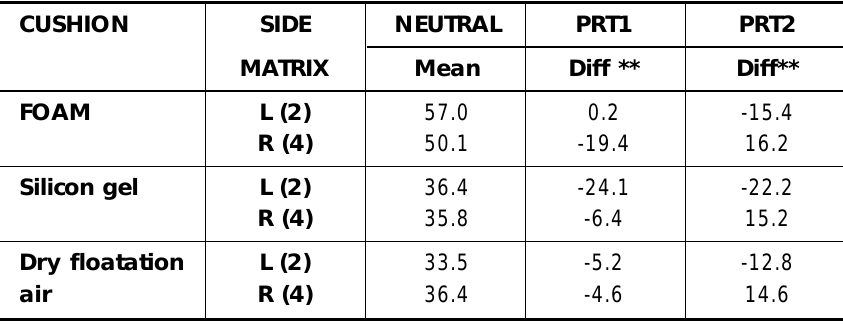
Table 2: A comparison of the mean of the six cells in matrices 2 and 4 that are situated over the upper thigh area (measured in mm